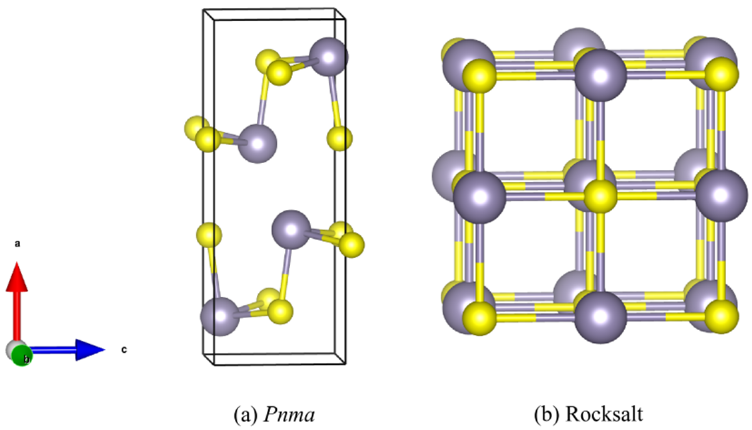
Figure 1. Representative structures of the Pnma ( a ) and rocksalt ( b ) phases of SnS and SnSe. These images were prepared using the VESTA software